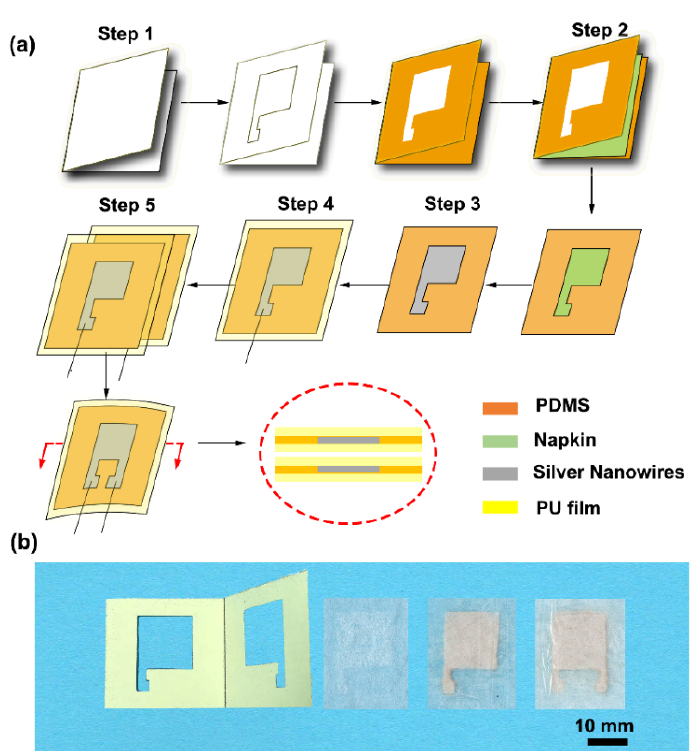
Figure 1. Schematic illustration of the fabrication of the napkin-based capacitive sensor. ( a ) Fabrication process. Step 1: A folded paper with hollowed pattern coated with polydimethylsiloxane (PDMS). Step 2: A piece of napkin is inserted into the folded paper, resulting in hydrophilic and hydrophobic pattern on the napkin. Step 3: Adding silver nanowires (NWs) in ethanol solution to the patterned napkin. Step 4: Packing it with PU film. Step 5: Two pieces of the electrode plates are coupling to form a capacitive sensor. ( b ) Photographs of the folded paper, hydrophilic–hydrophobic patterned napkin, single-electrode plate, and capacitive sensor.